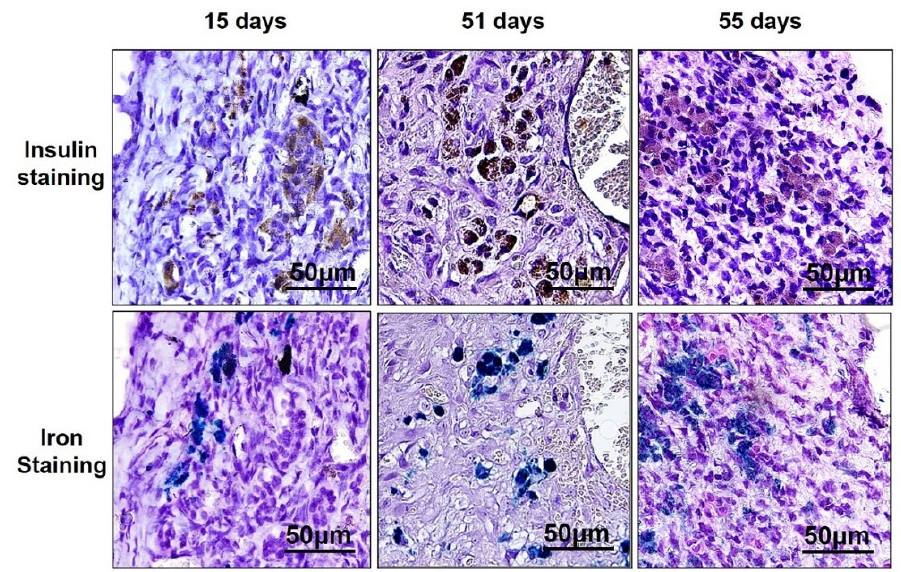
Figure 5. Insulin (brown color in upper panel) and Prussian blue (blue color in lower panel) staining of MnMEIO-Ex4 NP-labeled NPCC grafts removed at day 15, 51, and 55 post transplantation.